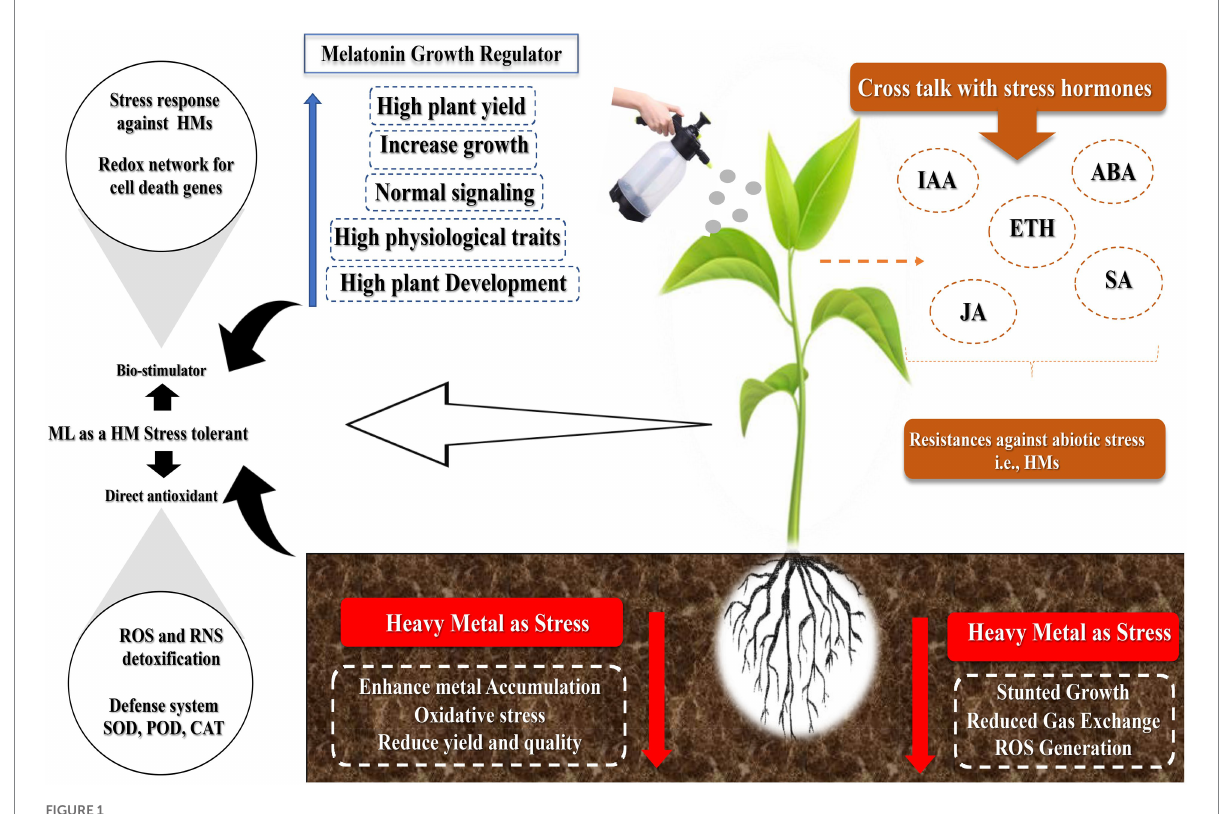
FIGURE 1 Graphical chart depicts the role of melatonin under abiotic stress